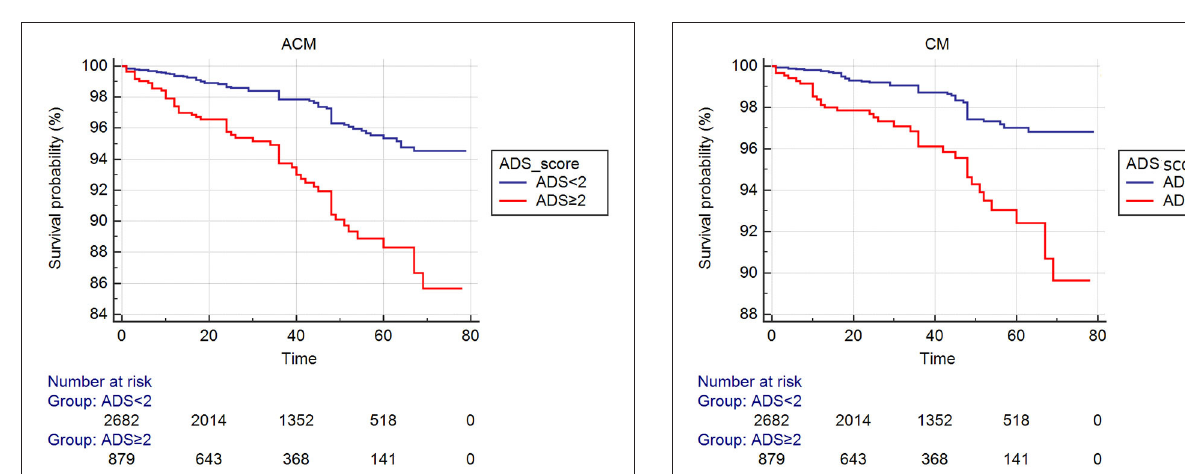
hypertension, LDL-C, treatment of β -blockers, ACEI or ARB between groups were not significantly different (all Ps ≥